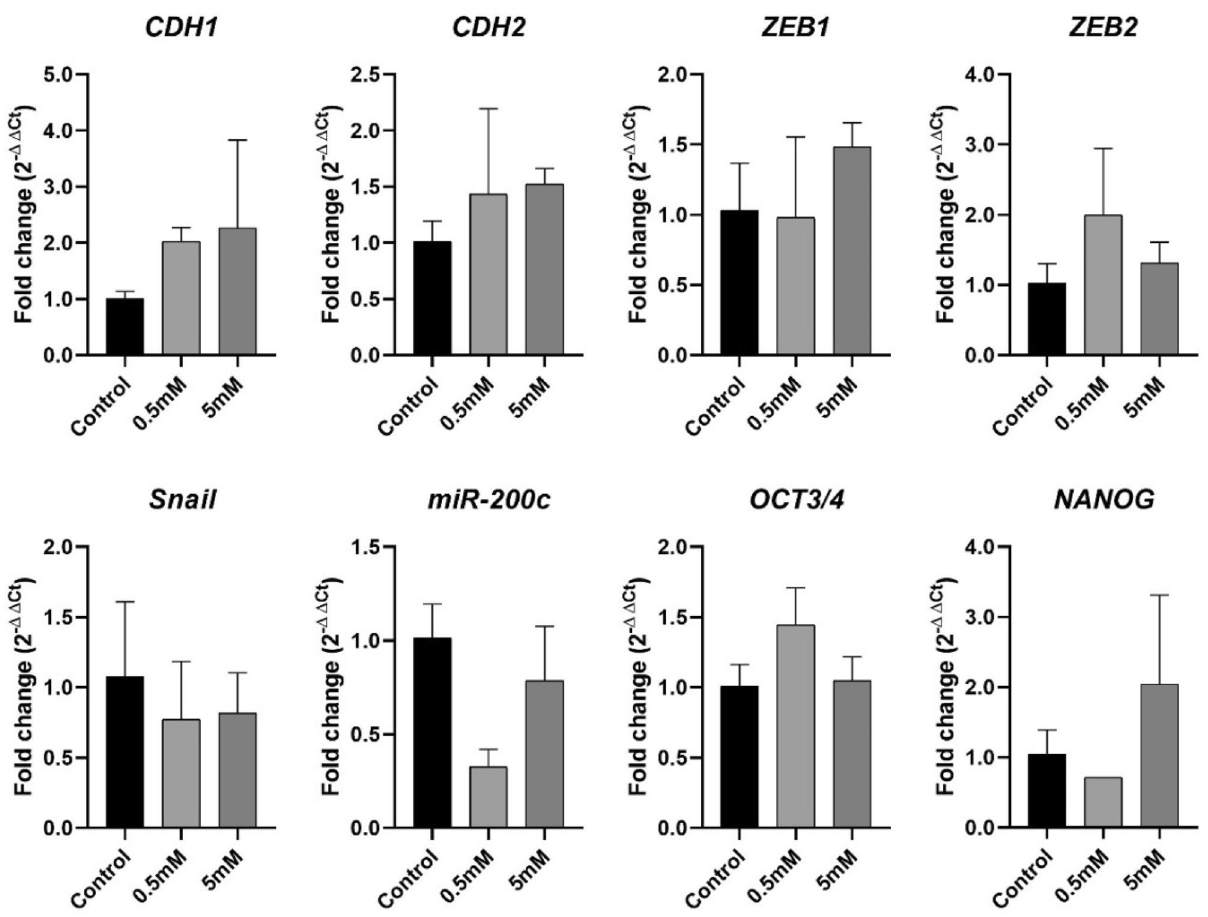
Figure 3. A-375 mRNA expression. A-375 cell line mRNA expression of EMT-related genes after 24 h of treatment with metformin at 0.5 mM and 5 mM. Data are plotted as mean ± SD of 2 −ΔΔCT , directly proportional to the relative gene